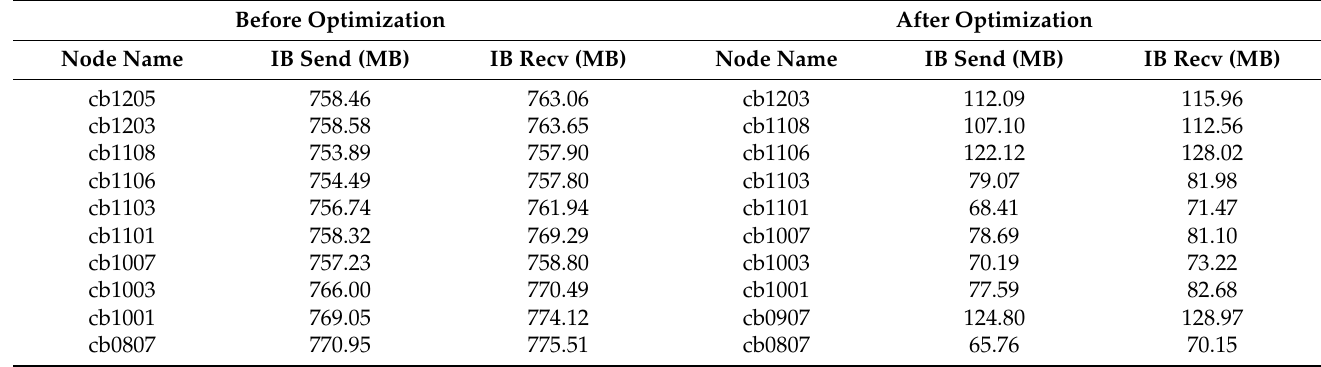
Table 3. The Paramon monitoring info of data exchange across nodes of 19-ring on Platform 1.